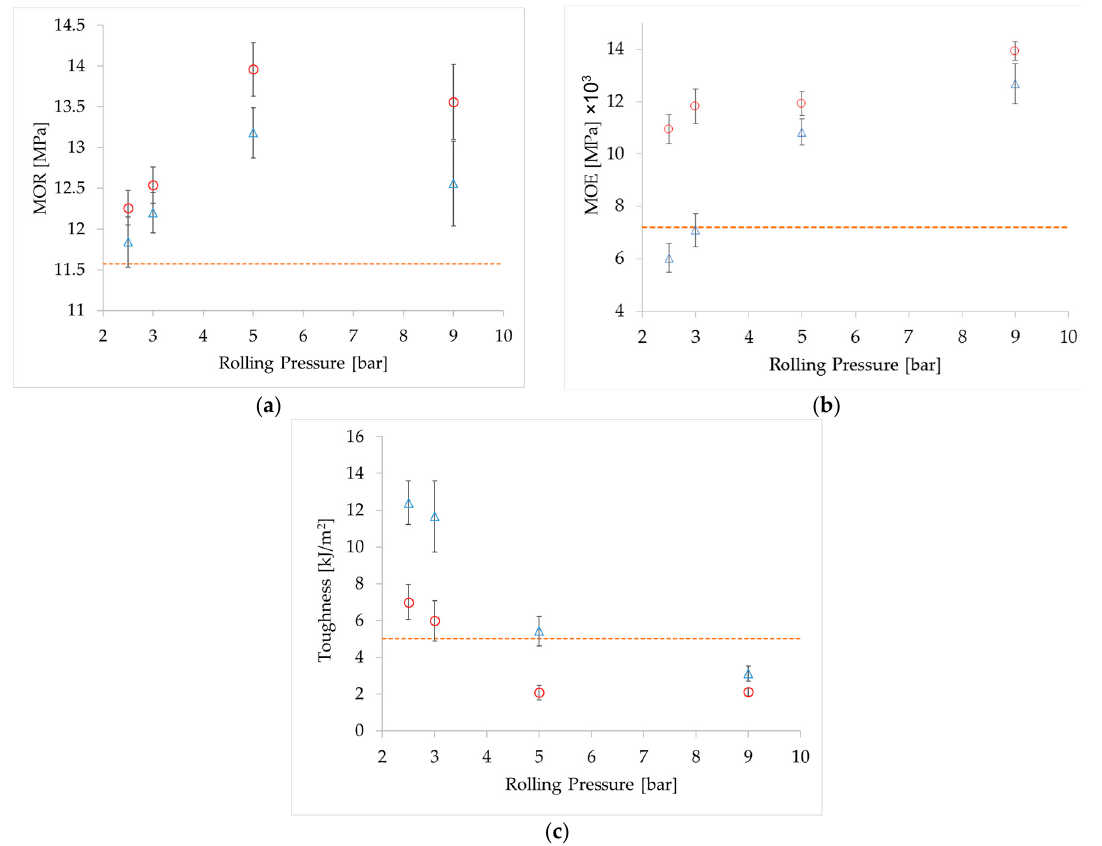
Figure 8. Average values of mechanical properties of non-carbonated and carbonated samples with di ff erent rolling pressures ( ∆ NCC, ● 5 h ACC, do tt ed lines represent minimum requirements): ( a ) Modulus of rupture (MOR); ( b ) modulus of elasticity (MOE) and ( c ) toughness.